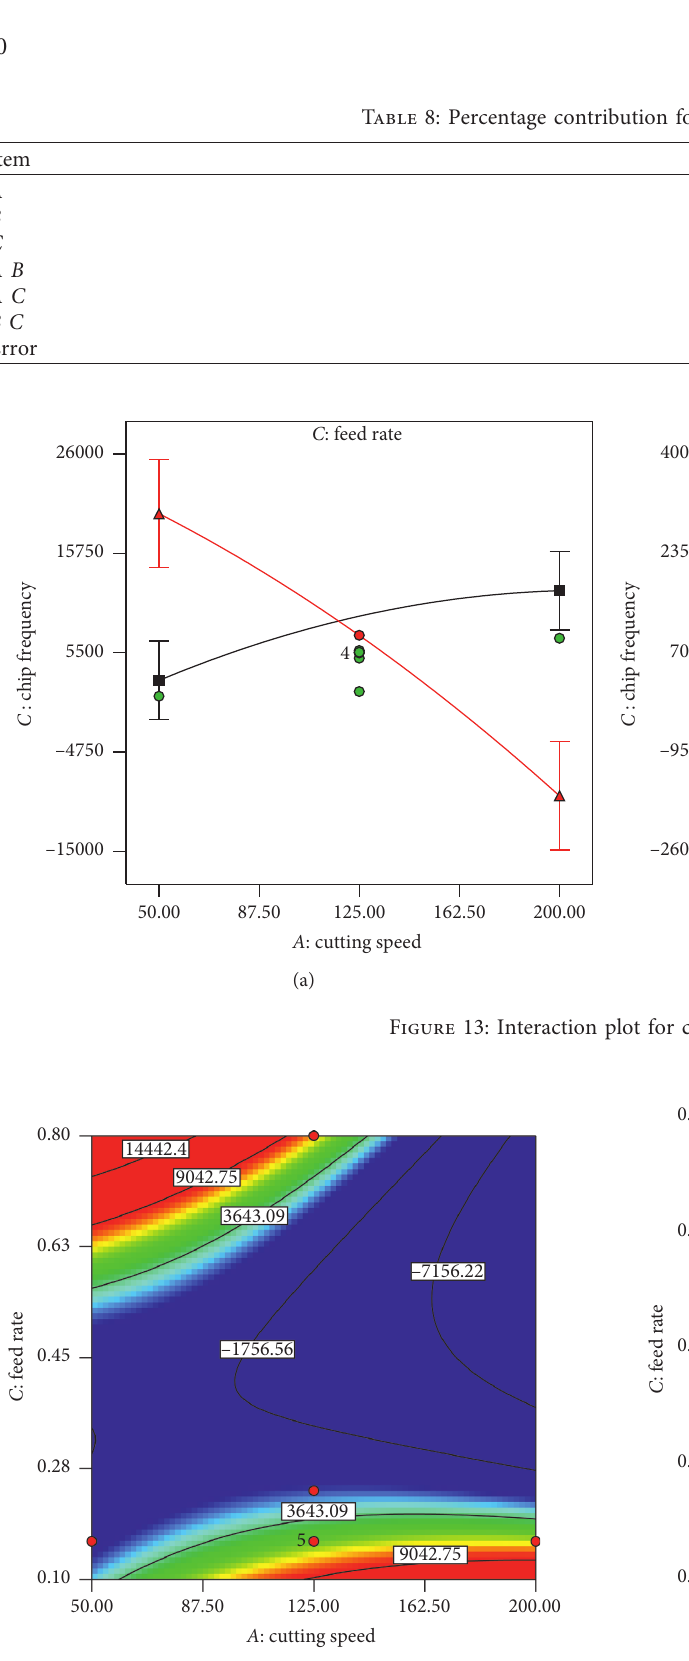
Figure 15: Chip frequency contour plots based on the depth of cut and feed